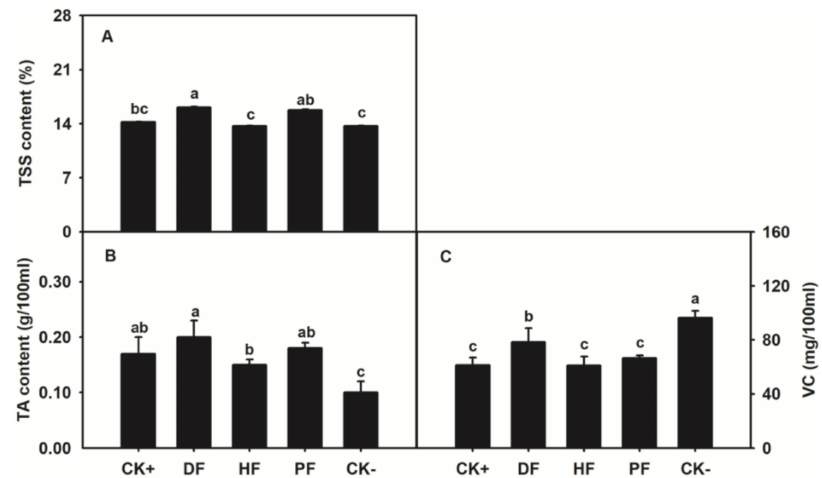
Figure 2. Effects of fertilization approaches on citrus fruit quality. ( A ) TSS, ( B ) TA and ( C ) VC contents. The data are presented as mean ± SD, n = 3. Different letters indicate significant differences at p < 0.05, Duncan’s test.